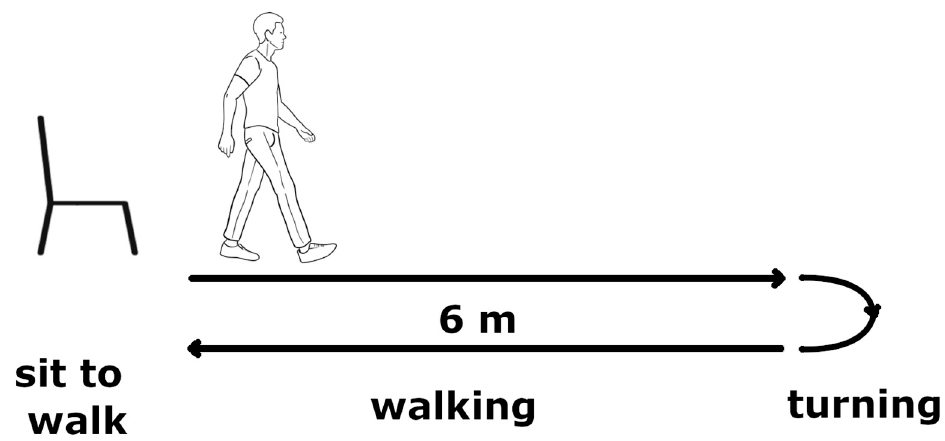
Figure 2. Graphical representation of different phases of Timed Up and Go test.